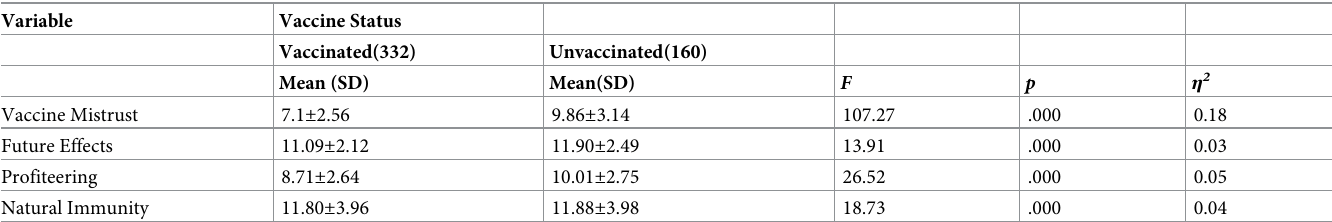
Table 2. Summary of MANOVA results for anti-vaccine attitudes